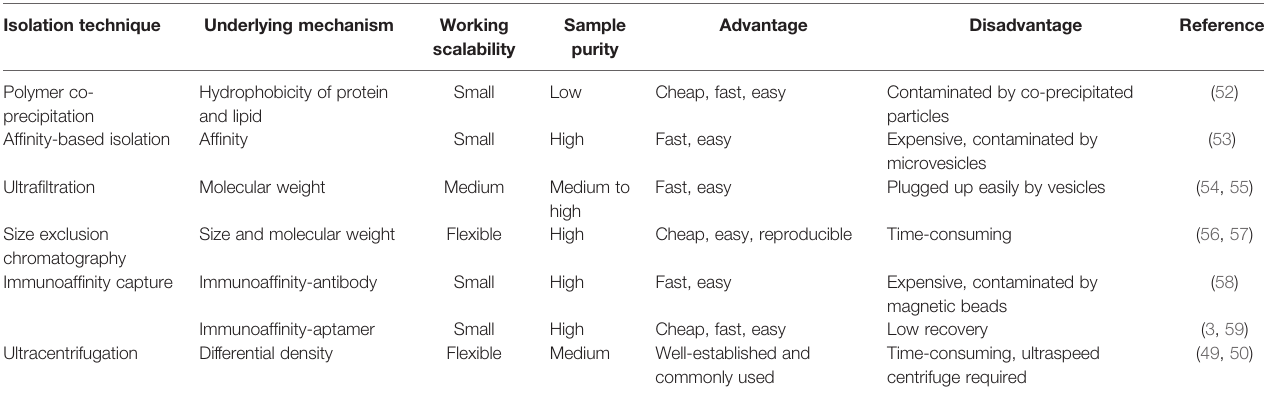
TABLE 1 | Comparison of different exosome isolation